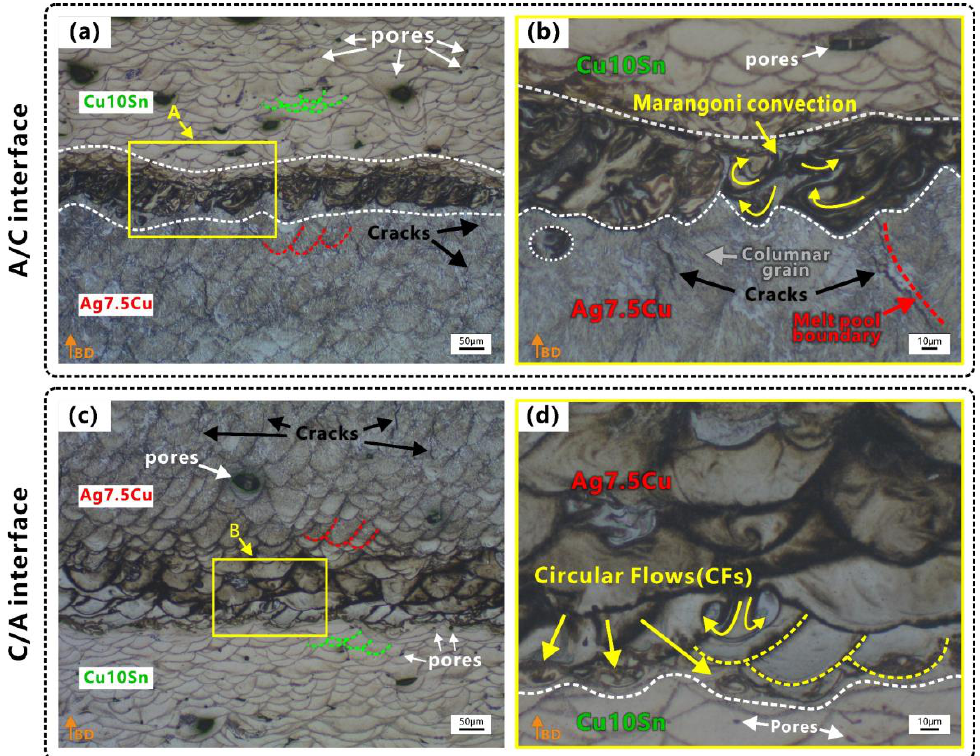
Figure 4. Characteristics of two interfaces after etching: ( a ) mesoscopic morphology at A/C interface; ( b ) enlarged view of area A in ( a ); ( c ) mesoscopic morphology at C/A interface; ( d ) enlarged view of area B in ( c ). Orange arrows indicate the building direction (BD).